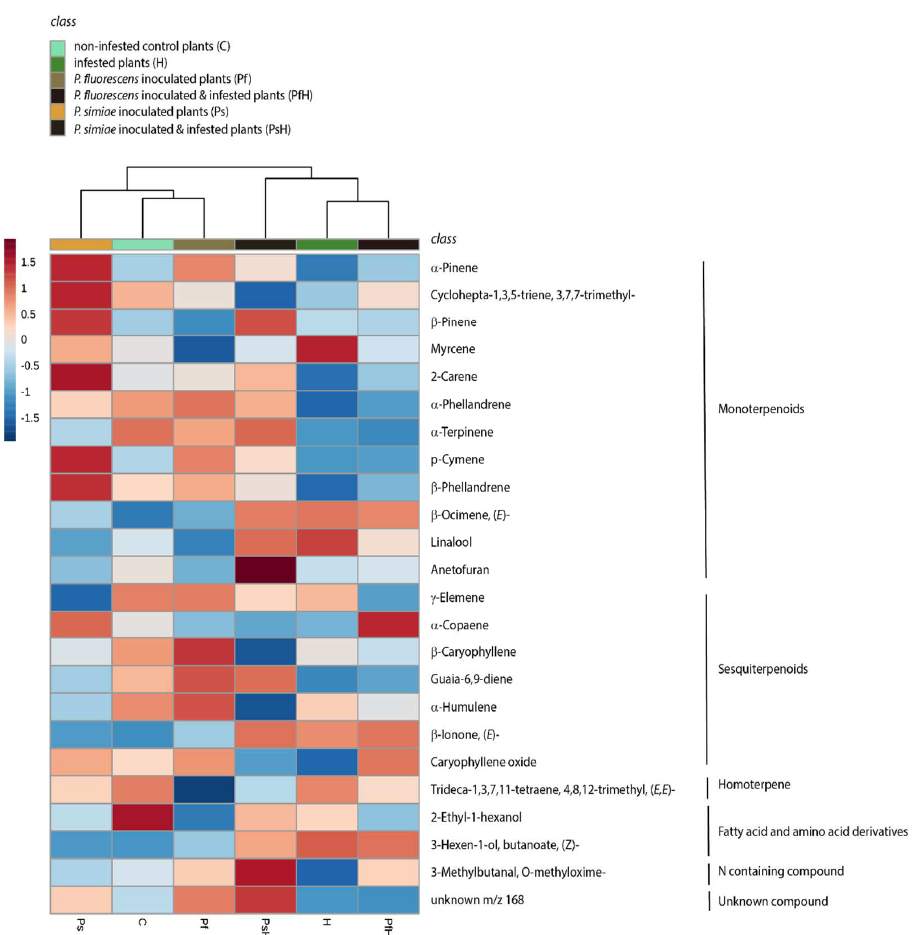
Figure 3. Dendrogram and heatmap of the emission of volatile compounds by tomato plants Solanum lycopersicum exposed to inoculation with one of two strains of rhizobacteria and herbivory by Spodoptera littoralis . Dendrogram clustering was performed using Ward’s clustering algorithm with Euclidean distances (peak height/g FW) for each compound. Each treatment had 15 replicates.